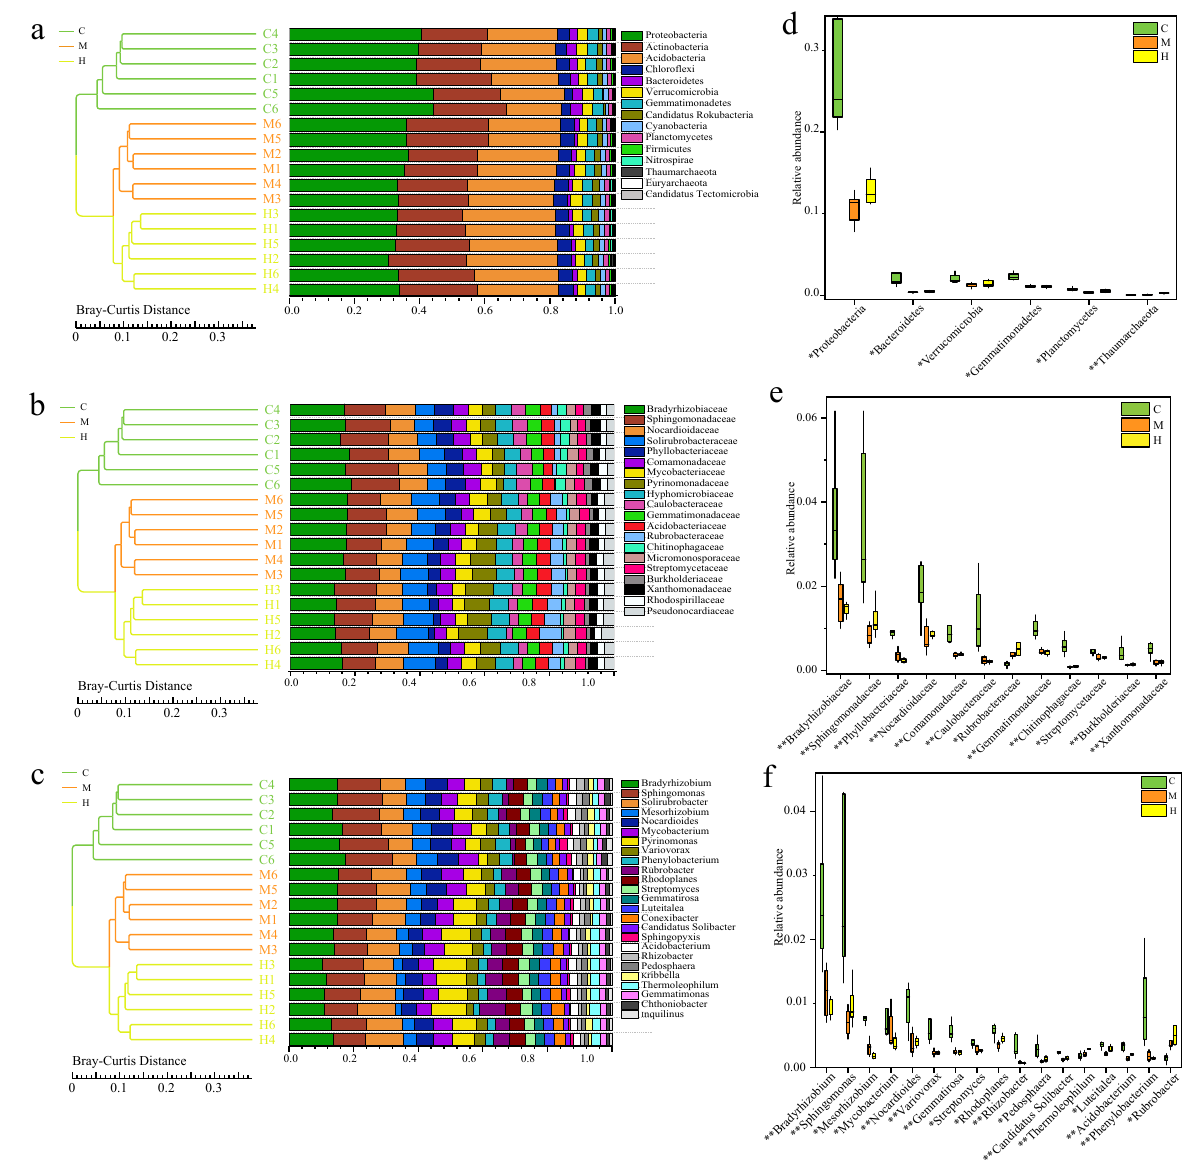
Figure 2. Comparative analysis of bacterial communities at different taxonomic levels. ( a – c ) Unweighted pair-group method with arithmetic mean (UPGMA) clustering based on Bray–Curtis distances and the relative abundance of the most abundant bacteria at the phylum, family, and genus level; ( d – f ) Indicator bacteria with significant differences between C, M, and H groups. “*” represents adjust q value < 0.05, “**” represents adjust q value <